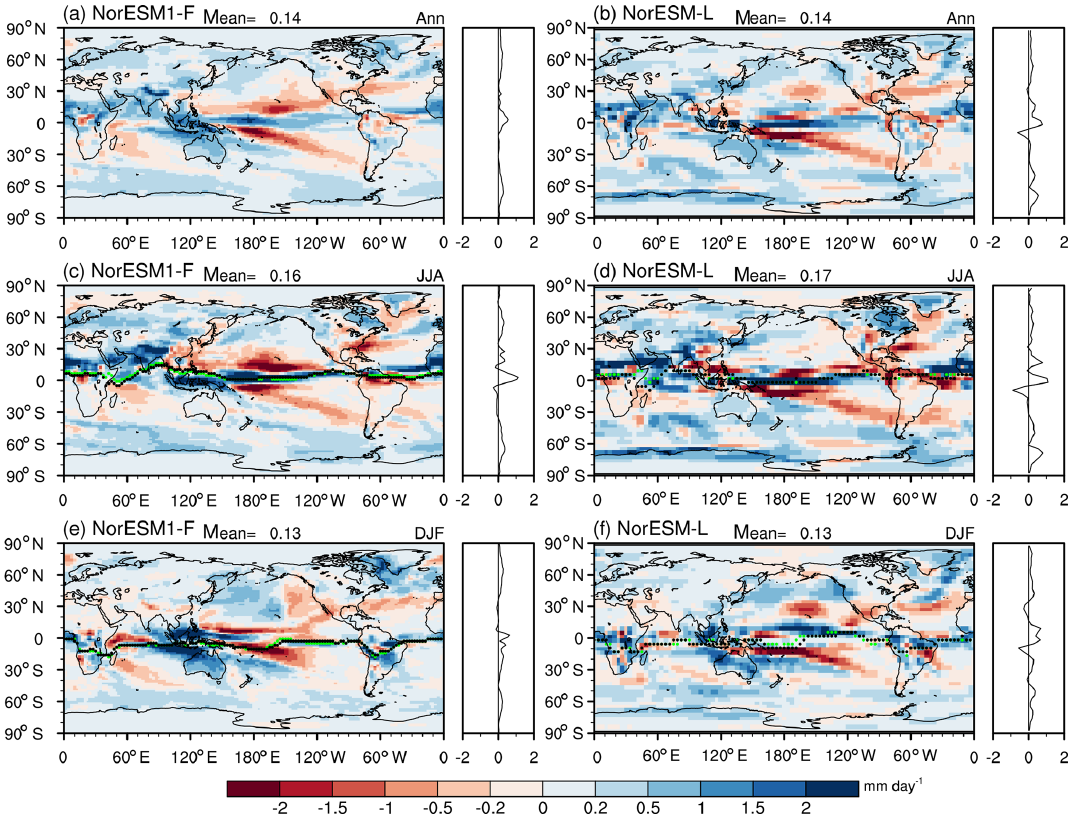
Figure 2. Same as Fig. 1 but for precipitation (units: mmd − 1 ). The black and green dots in (c) , (d) , (e) , and (f) indicate the positions of the ITCZ in the preindustrial and Pliocene experiments, respectively, as defined by Braconnot et al.